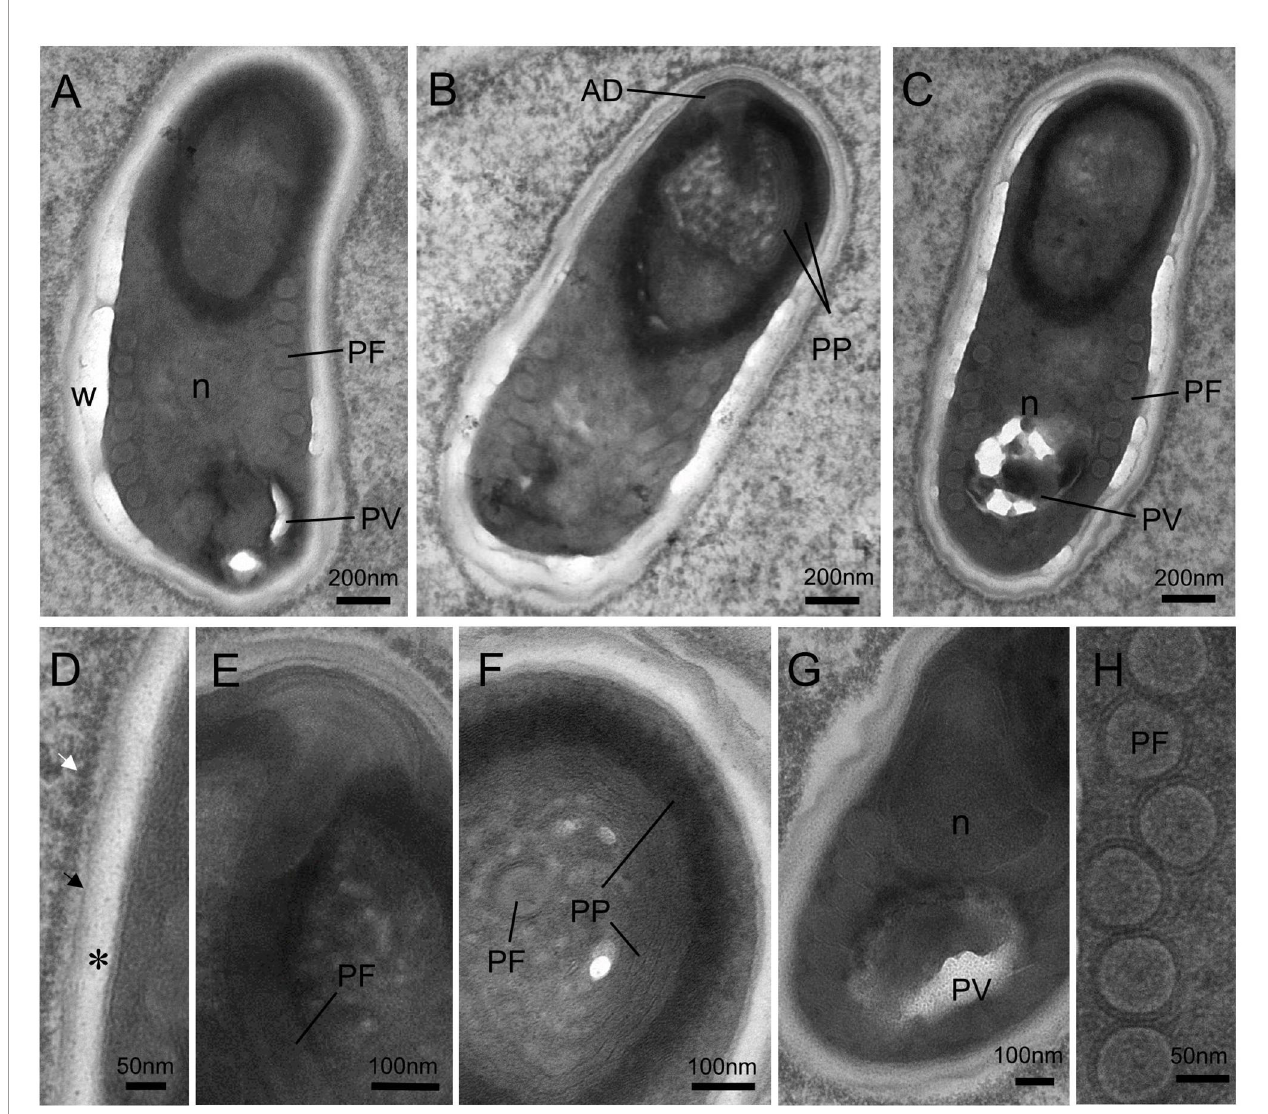
FIGURE 6 | Transmission electron micrographs showing the ultrastructure of mature spores of Nucleospora hippocampi n. sp. in the Hippocampus erectus . (A – C) Three spores showing the typical microsporidian structures and organelles. The spore wall (W), anchoring disk (AD), polaroplast (PP), posterior vacuole (PV), polar fi lament (PF), and the single nucleus (n) are indicated. (D) Ultrastructural detail of spore wall showing the exospore (black arrow), the endospore (asterisk), and the plasmalemma (arrowhead). Notice the electron-dense materials deposited on the outer surface of the exospore (white arrow). (E) Detail of terminal anchoring disk and associated polar tube (PF). (F) High magni fi cation of a transverse section of a spore showing the lamellar region of the polaroplast (PP). (G) The single nucleus (n) is situated beside the posterior vacuole (PV). (H) Detail of the iso fi lar polar fi lament